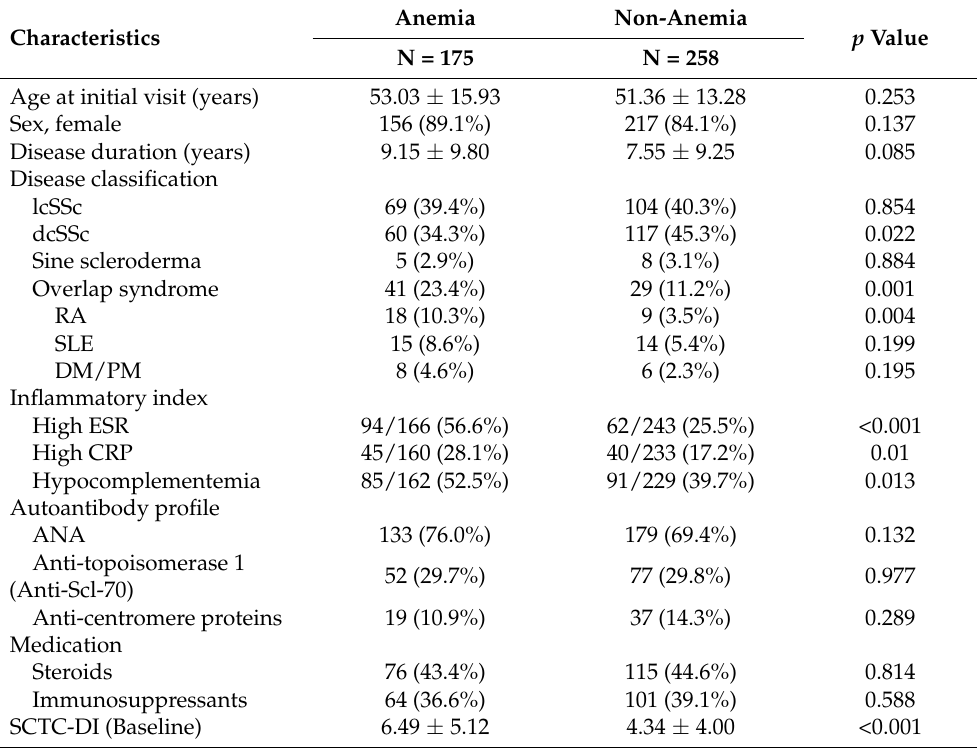
Table 4. Clinical characteristics of SSc patients with and without